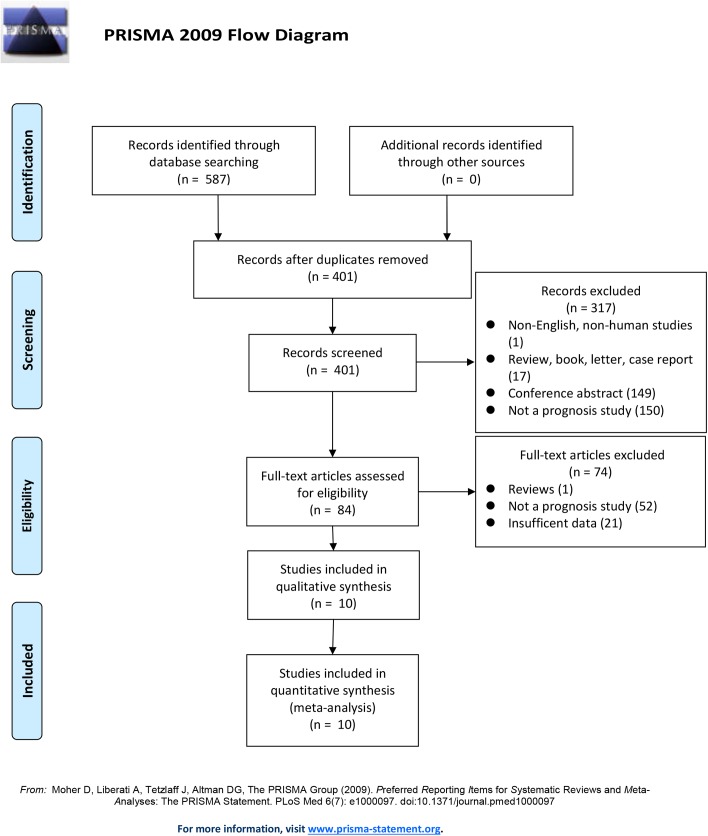
Flow chart of study selection.